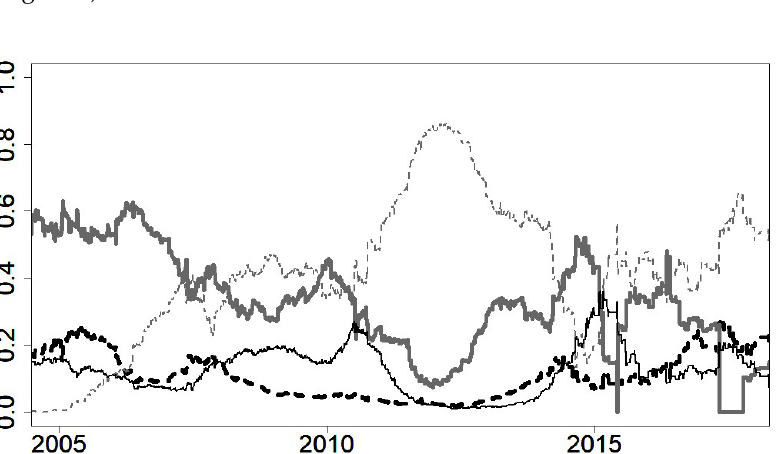
Figure 3. Proportion of single stocks (thin black solid), indices (thick black dashed), baskets (thick gray solid) and multiple assets (thin gray dashed) as underlyings of capital protected products and interest rate levels from 2004 to